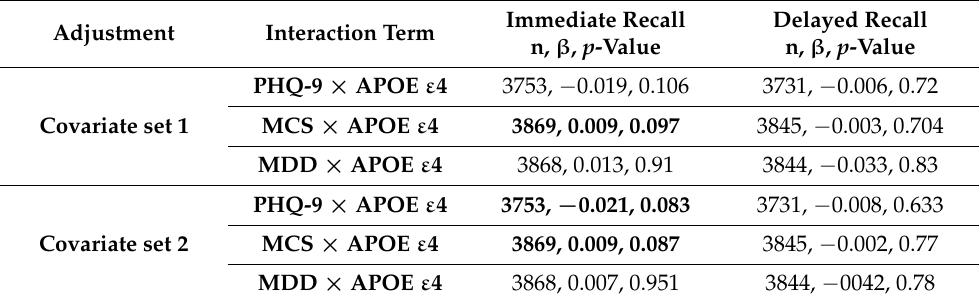
Table 3. Results of the interaction analyses between depression variables and APOE ε 4 status on the endpoint verbal memory (NAI) in TREND under the adjustment of two different covariate sets.